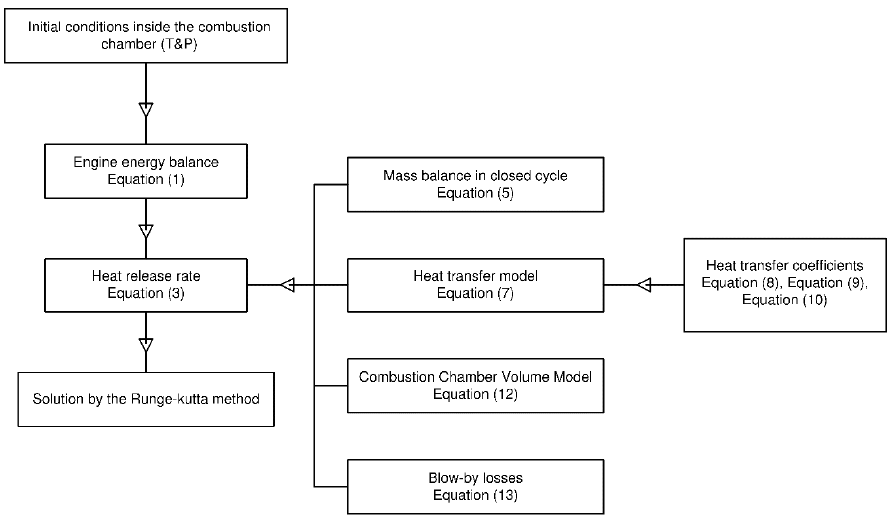
Figure 2. Flow chart of the diagnostic model.